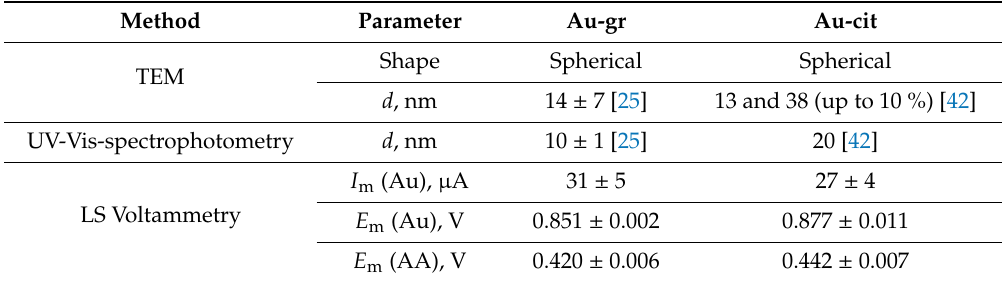
Table 1. Comparative characteristics of Au-gr and Au-cit nanoparticles.